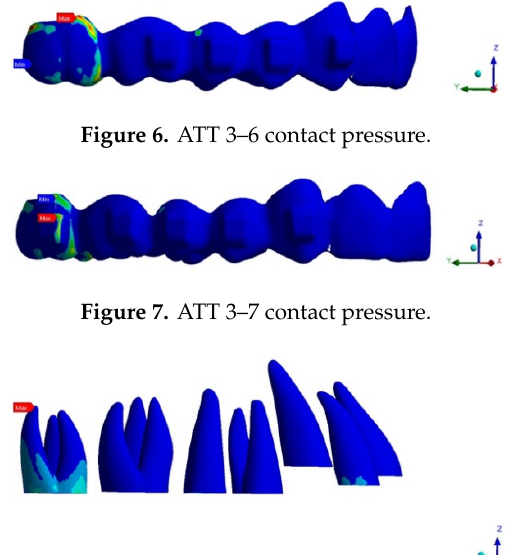
Figure 5. NO ATT contact pressure.